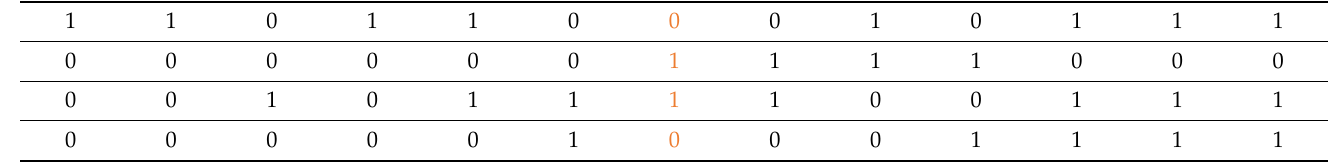
Table 12. New chromosome derived from the vertical mutation